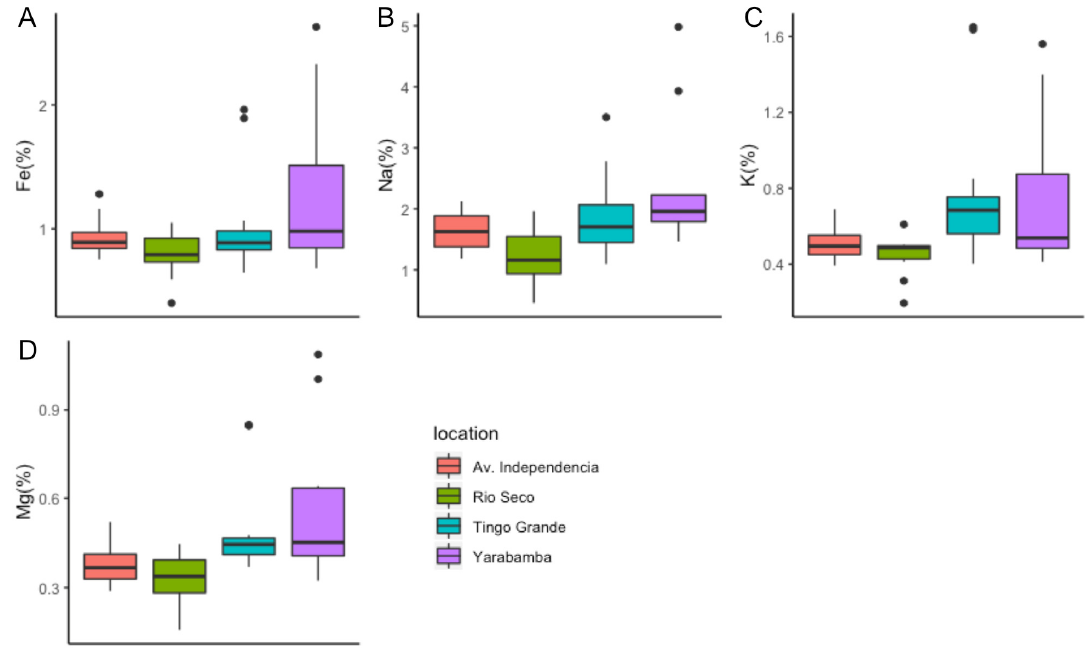
Figure 3. Box plot of major element concentrations ( A : Fe, B : Na, C : K, D : Mg, in %) at each site.